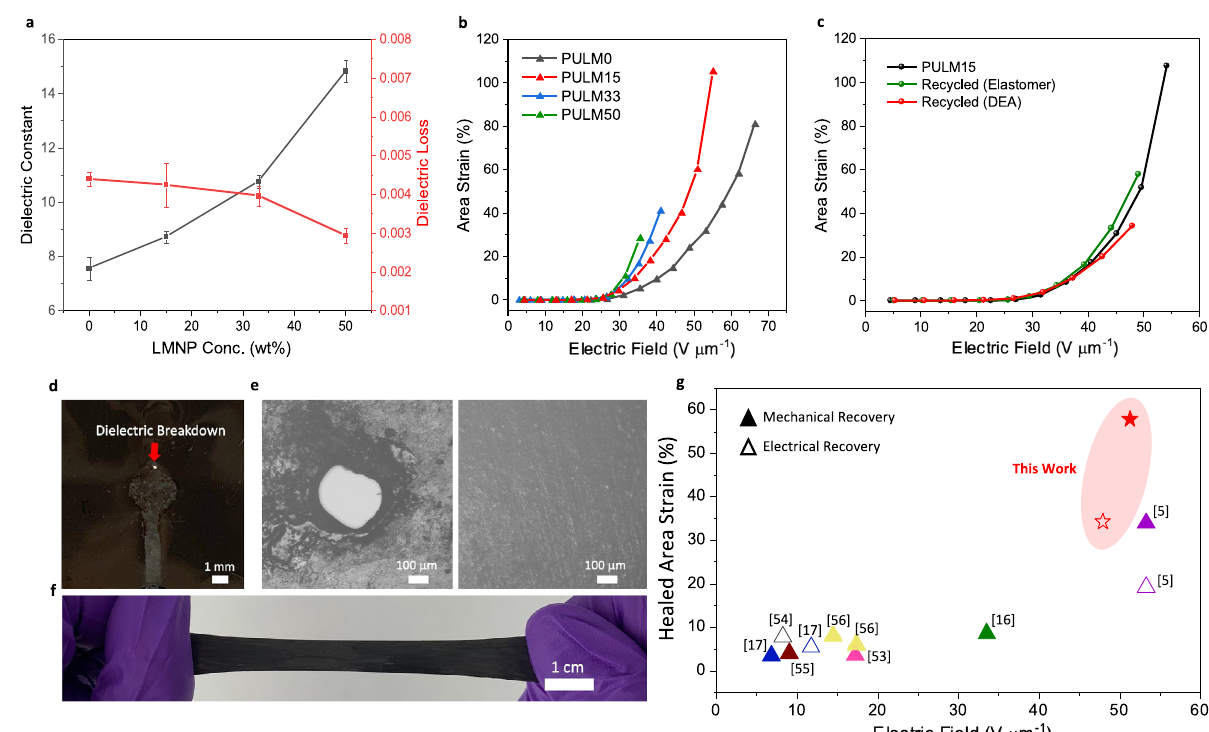
Fig. 4 | Performance of resilient DEAs. a Dielectric constant and loss of PULM nanocomposites. Error bars are the standard deviation of fi ve independent sam- ples. b Representative area strains achieved by PULM nanocomposite DEAs. Area strains calculated are based on geometric relations from out-of-plane displace- ments of the buckled electroactive regions. c Representative area strains achieved by PULM15, recycled PULM15 after mechanical damages (cut into pieces) and electrical damage (dielectric breakdown). d Hole observed at the electrode area is